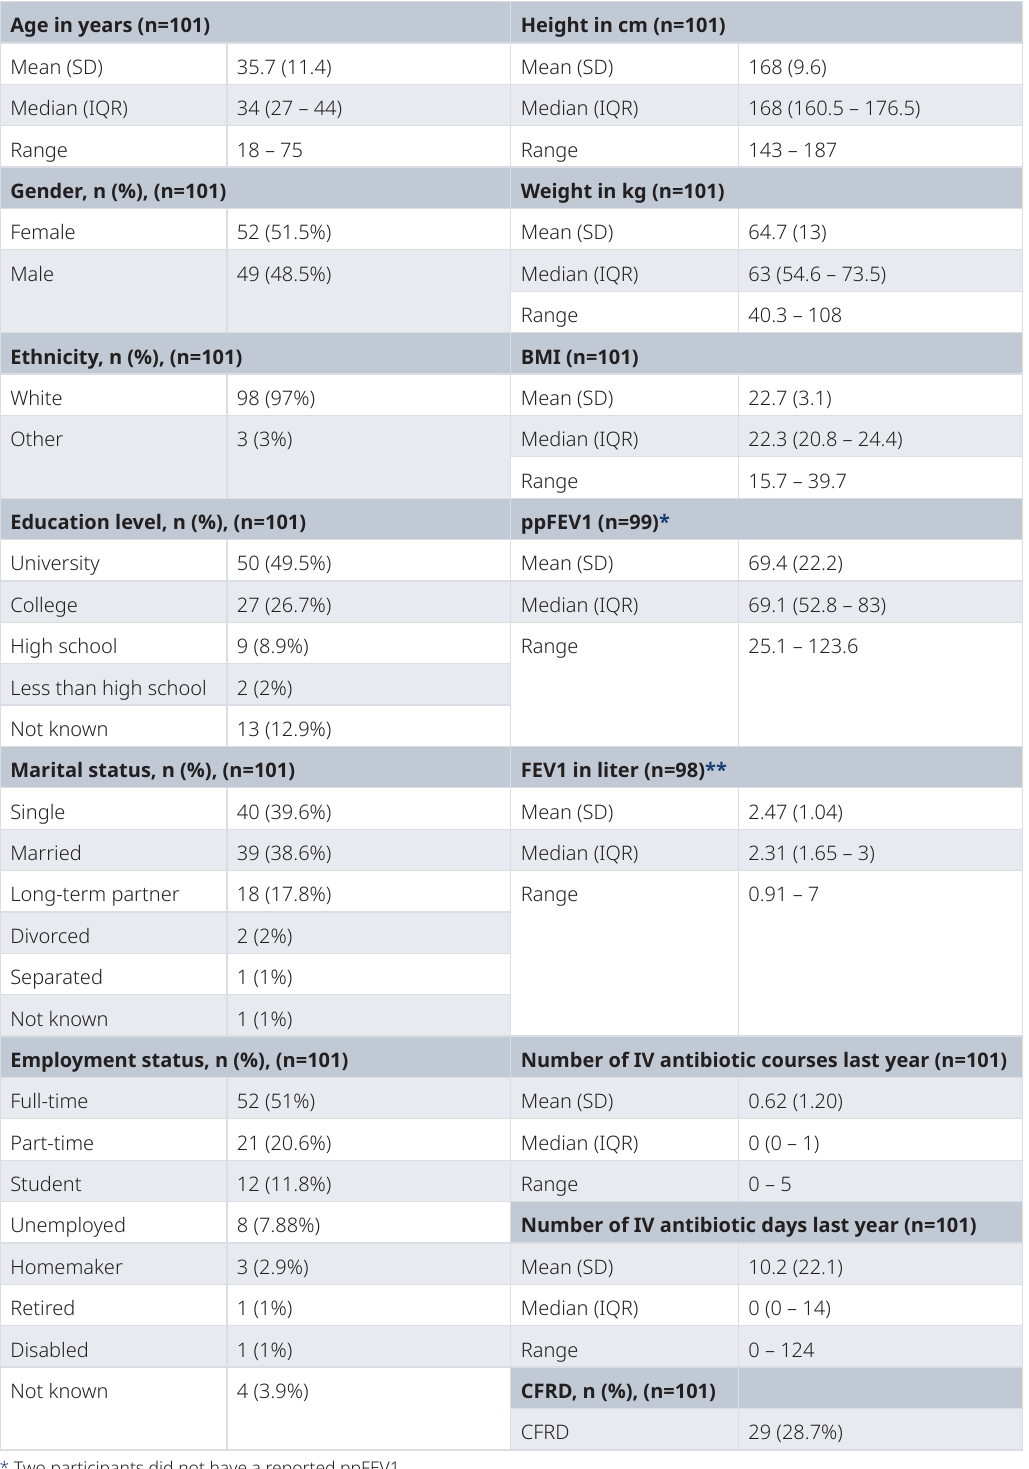
Table 3. Demographic and clinical variables for the